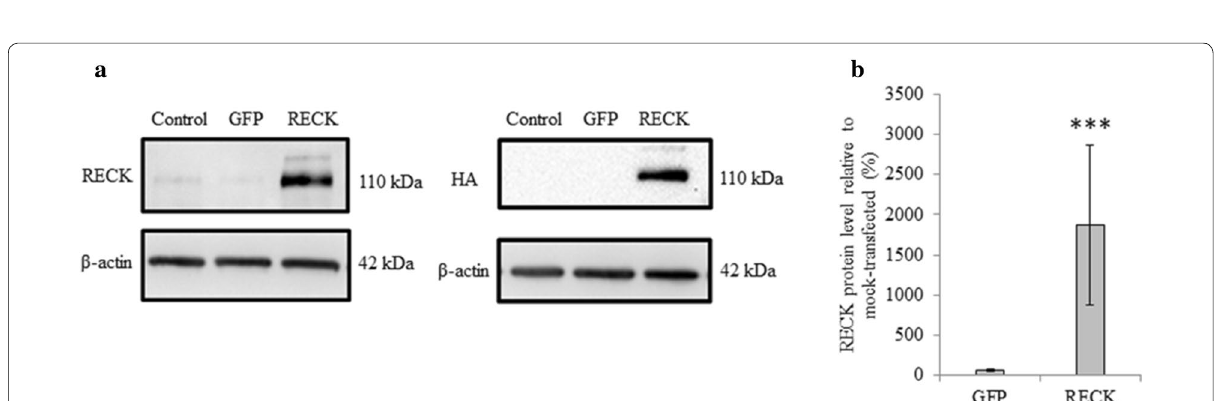
Fig. 3 Transfection of full-length HA-tagged RECK constructs in A6 cells resulted in increased RECK levels. a Immunoblot analysis was used to confirm overexpression of RECK protein following transfection of RECK cDNA constructs. Mock-transfected and GFP-transfected A6 cells were used as controls. Protein was extracted from cells 24 h following transfection. β-actin is used as a loading control. Left panel demonstrates increased levels of RECK protein compared to control using a RECK antibody, while right panel confirms the presence of HA-tagged proteins only in RECK-transfected A6 cells using an HA antibody. b Graphed data is based on 3 biological replicates (mean SD) and normalized to control (set to ± 100%). Data is analyzed via t-test; ***, p ≤